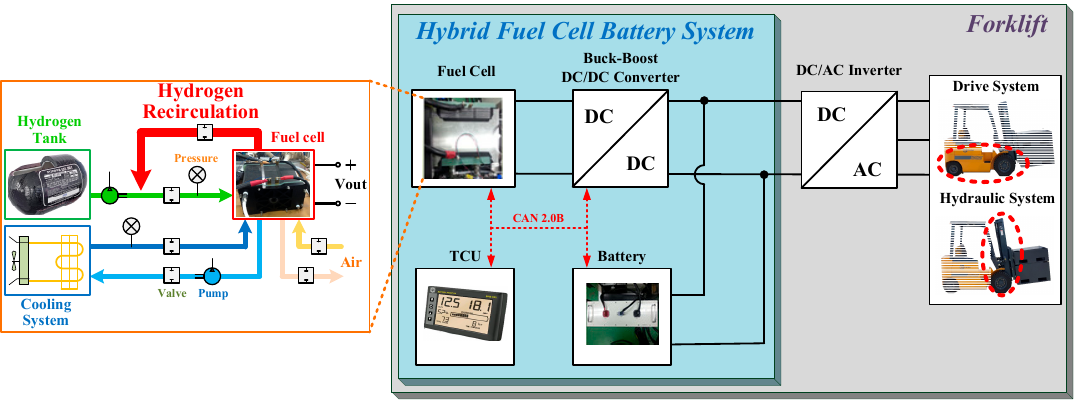
Figure 1. Configuration diagram of hybrid fuel cell battery for a forklift, including hydrogen recirculation. TCU, total control unit.